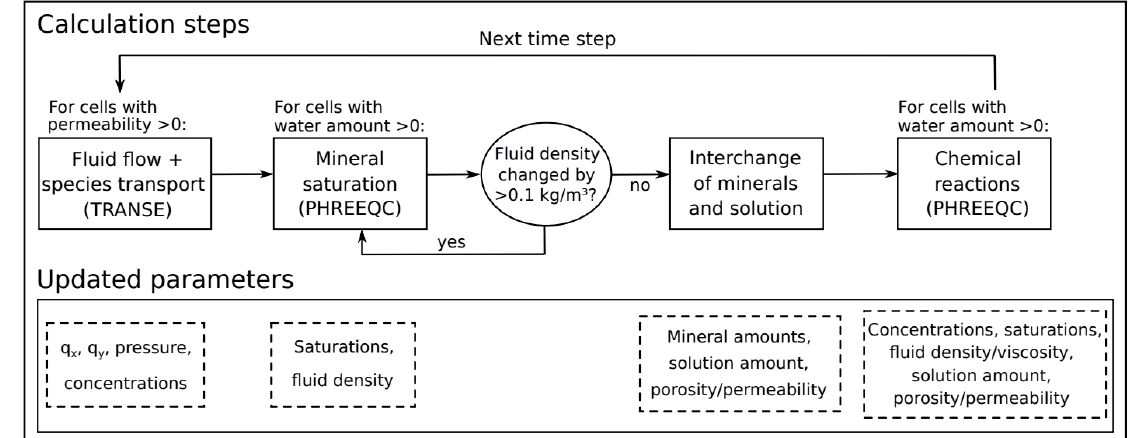
Figure 2. Flow sheet of the coupled reactive transport model: calculation steps in each time step and associated output Figure 2. Flowsheetofthecoupledreactivetransportmodel: calculationstepsin parameters.